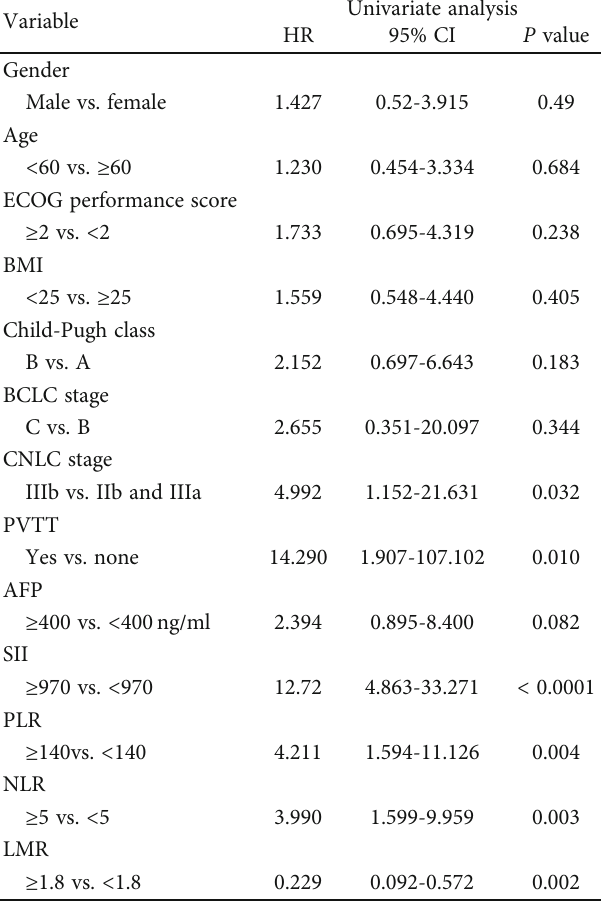
Table 2: Univariate Cox proportional hazards regression models for progression-free survival.